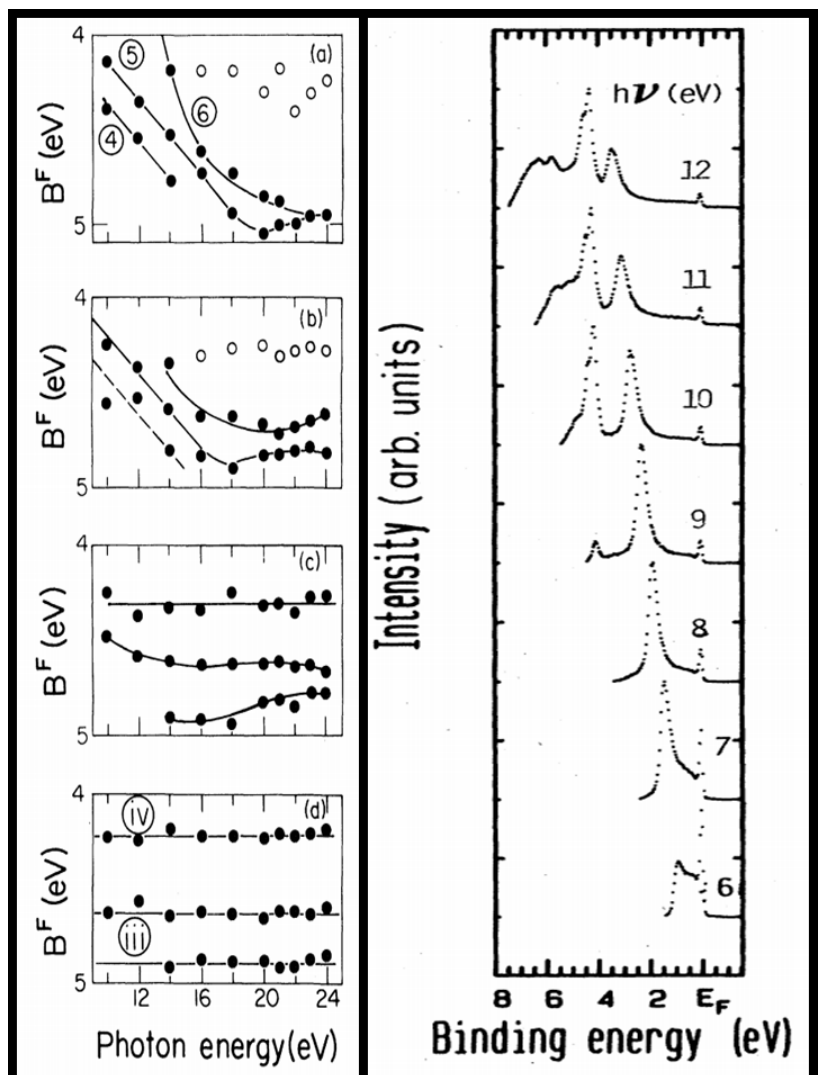
Figure 3. Normal emission ARPES results for Ag/Cu(001) and Ag(111). Left panel: the Ag/Cu(001) dispersion along normal emission increases as the thickness of the over-layer increases, moving towards the limit of Ag(111)-like behavior. B F is the binding energy versus the Fermi level. ( a ) Ag(111); ( b ) 5 Monolayers (ML) of Ag; ( c ) 4 ML; ( d ) 2ML of c(10x2)Ag/Cu(001). Right panel: strong dispersion